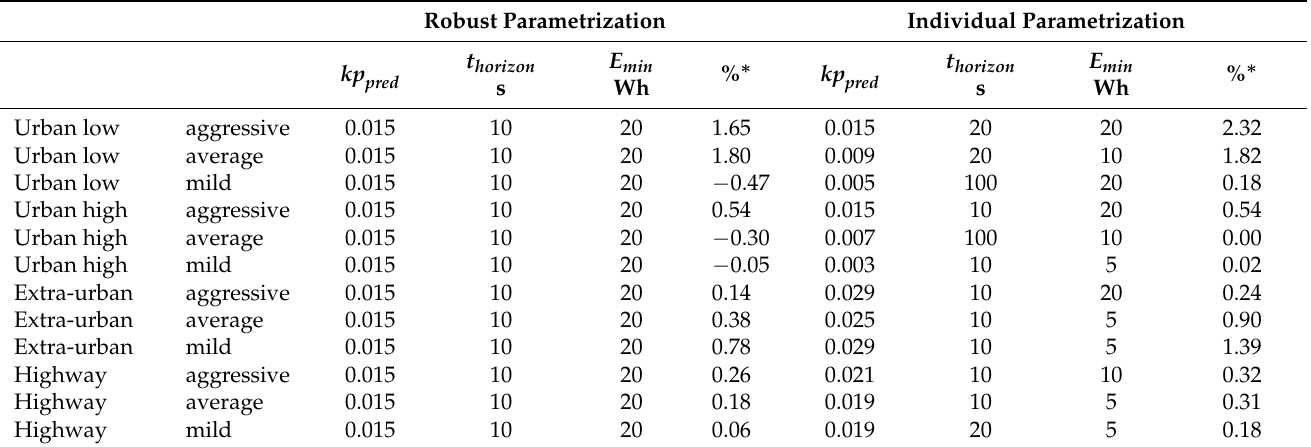
Table 6. Results of proposed Online ECMS with robust (left) as well as individual parametrization (right) for a 25 Wh battery using λ 0 = 2.90 and kp SOC =